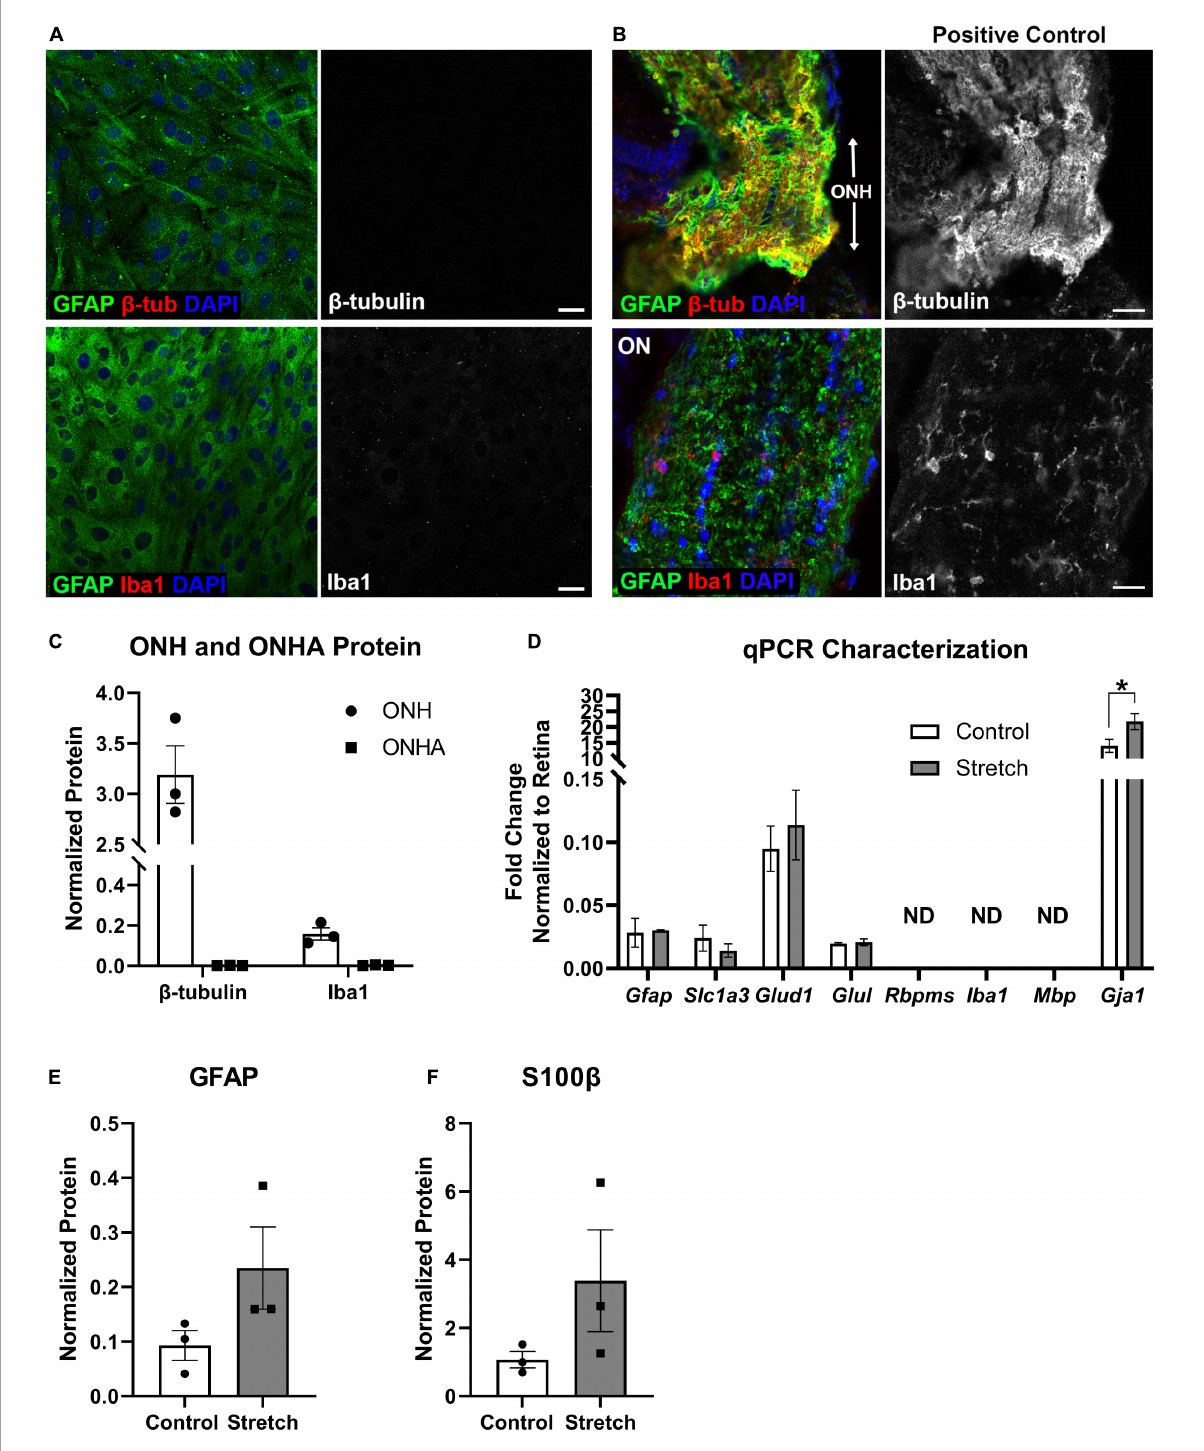
FIGURE1 Optic nerve head astrocyte characterization . (A) Isolated optic nerve head (ONH) astrocytes were immunolabeled using antibodies against GFAP (green), β -tubulin (red, upper panels), and Iba1 (red, lower panels) to determine the purity of the cell cultures. DAPI was used to stain cell nuclei (blue). Neither β -tubulin nor Iba1 was detected in the cultures. Scale bar = 10 µ m. (B) Sections of retina with ONH and optic nerve attached served as positive controls for the immunolabeling in (A) . Both β -tubulin and Iba1 were observed in the mouse ONH and optic nerve. Scale bar = 25 µ m. (C) Quantification of β -tubulin and Iba1 protein in the optic nerve head (ONH) and isolated ONH astrocytes using capillary electrophoresis. Neither β -tubulin nor Iba1 was detected in the ONH astrocyte cultures (square symbols); n = 3 biological replicates per